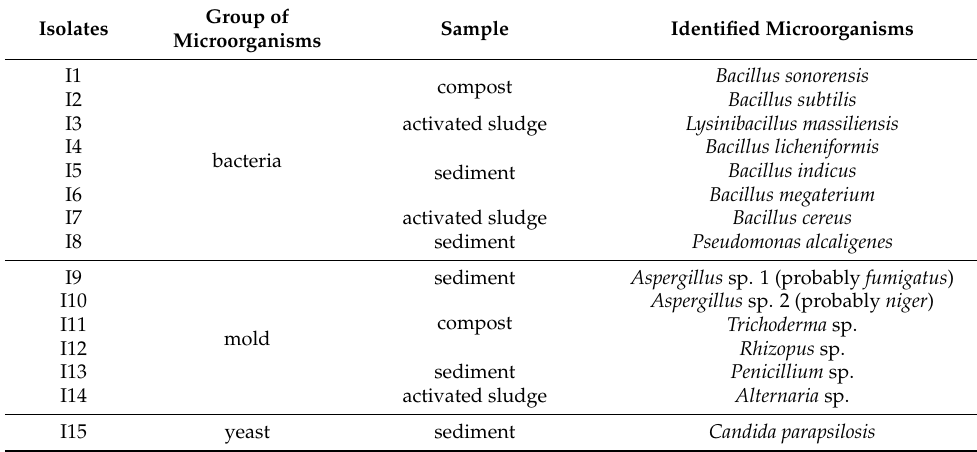
Table 2. The list of isolated and identified microorganisms from three environmental